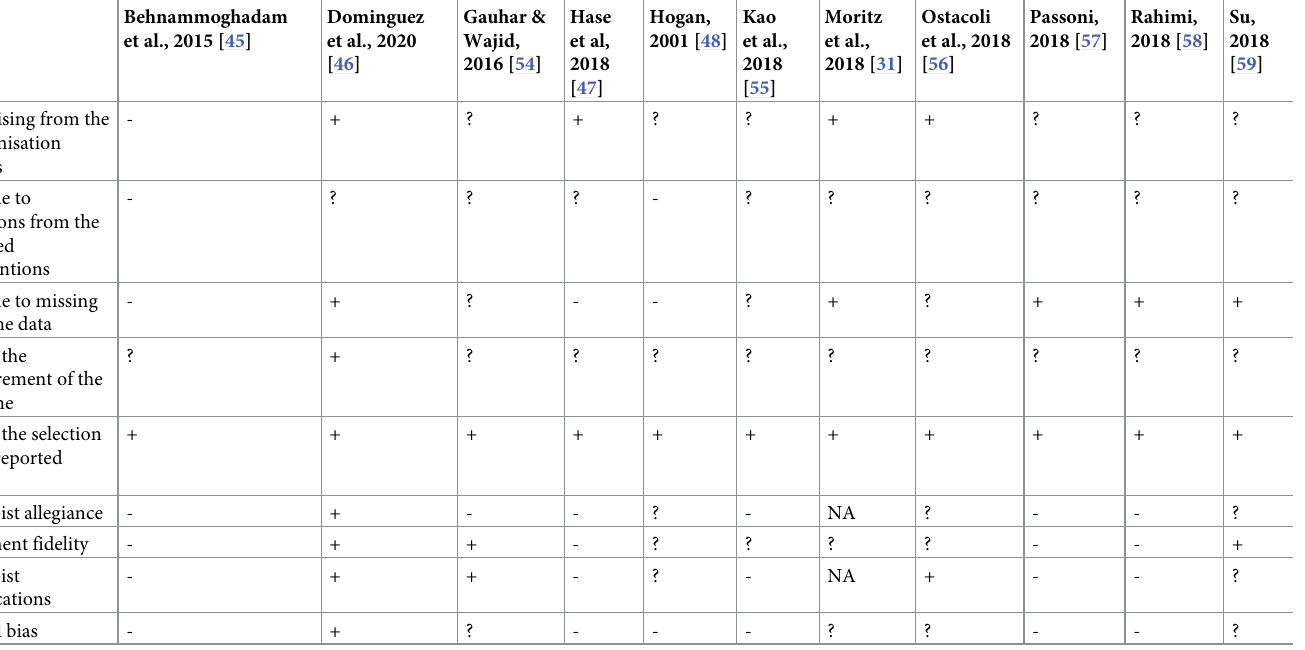
Table 2. Quality assessment: Risk of bias.